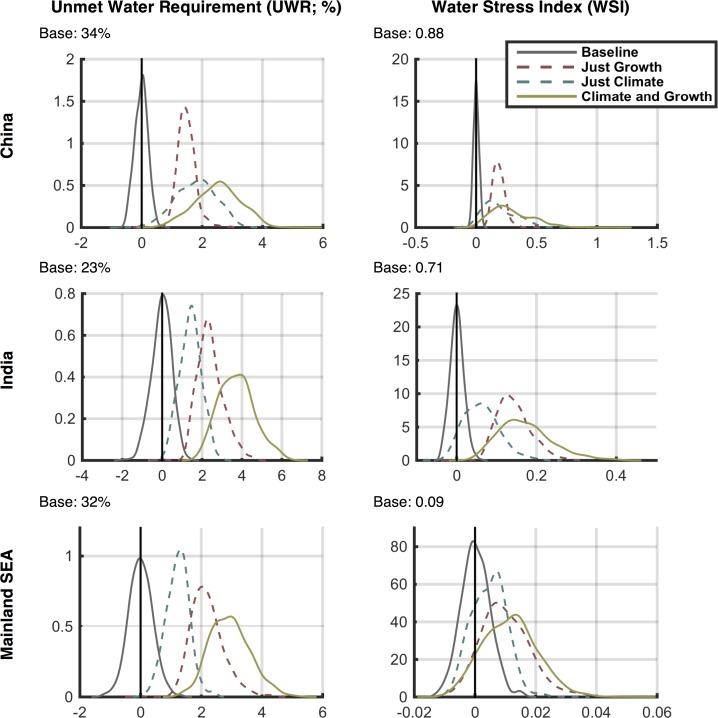
Frequency distributions of changes in decadal averaged Unmet Water Requirement (UWR, left column) and water stress index (WSI, right column) for 2041–2050 against the baseline result aggregated over major socio-economic regions (Fig 28) and weighted by population.Mean baseline value shown above each figure. Results are shown for the Just Growth, Just Climate, and Climate and Growth ensemble scenarios. In addition, a distribution for the Baseline result is also provided that depicts the range of UWR and WSI decadal-averaged changes that would result from internal variability of the climate forcing (see text for details).